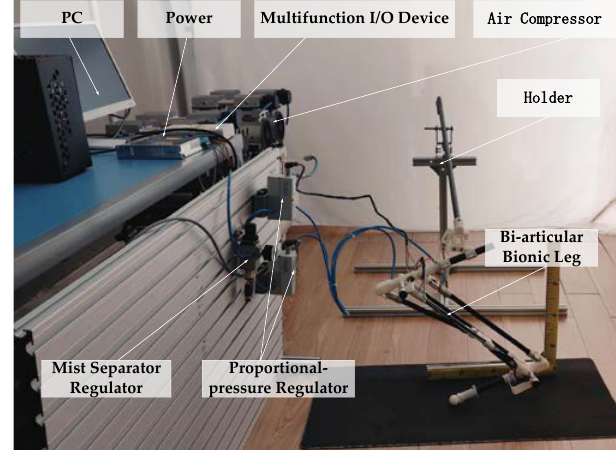
Figure 9. Bionic leg experimental platform.